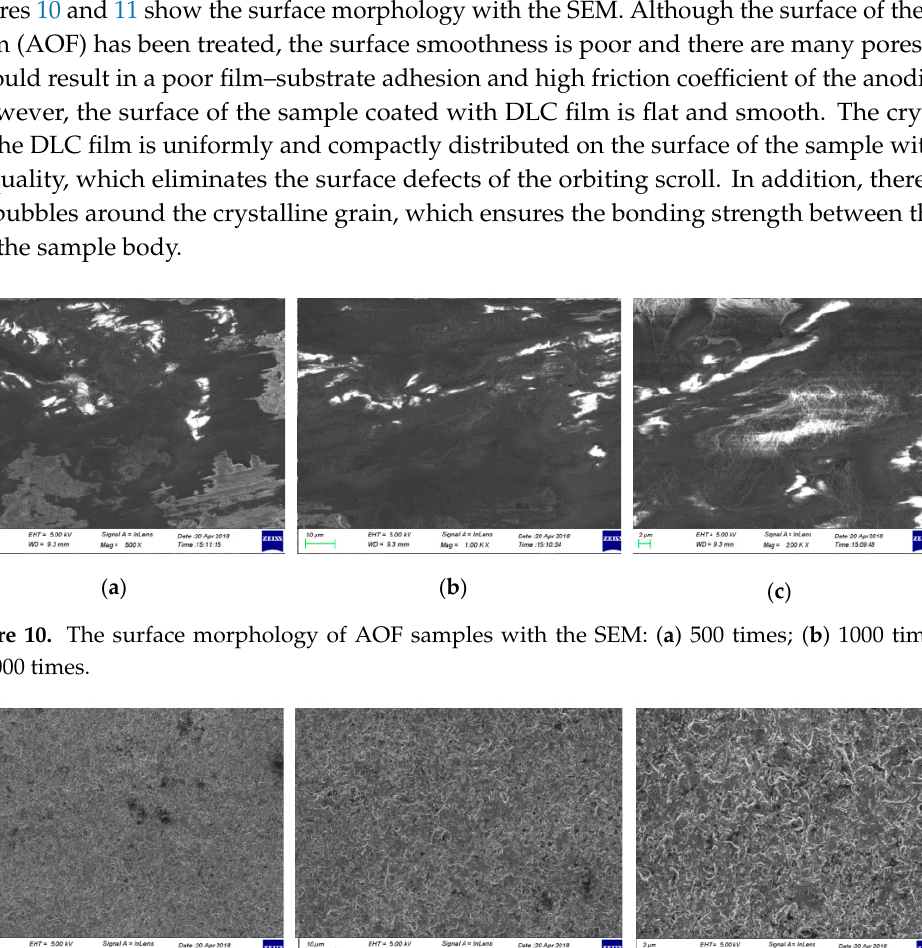
Figure 12. The X-ray diffraction spectrum of the AOF and the DLC film.